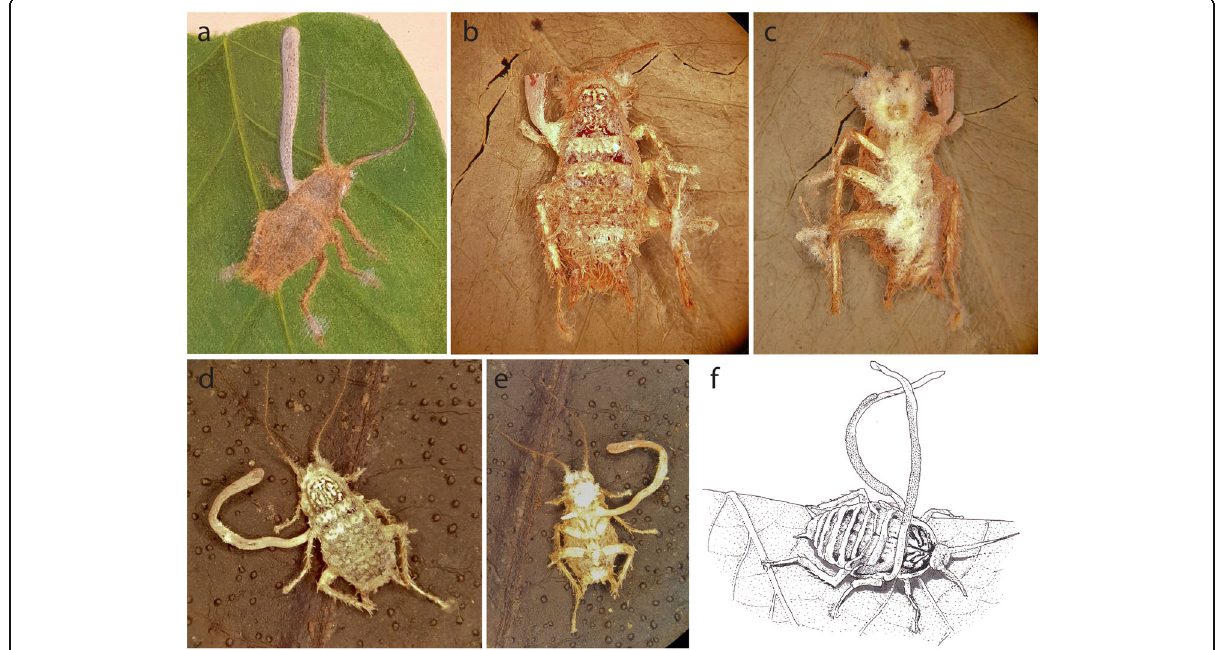
Fig. 1 Ophiocordyceps blattae and O. cf. blattae . a the original illustration of O. blattae showing the ascoma emerging laterally from the host thorax (Petch 1924). b and c (K98612 – holotype deposited in the Kew Gardens Fungarium). d and e Additional specimen collected by Petch in 1914, same location as the holotype K(M)264510. f O. cf. blattae from Thailand used in this study with two ascomata arising laterally on both sides (deposited at Biotech Fungal Collections as MY34765) (del. M. G. Moriguchi). a – e ; images by Lee Davis, Royal Botanic Garden,